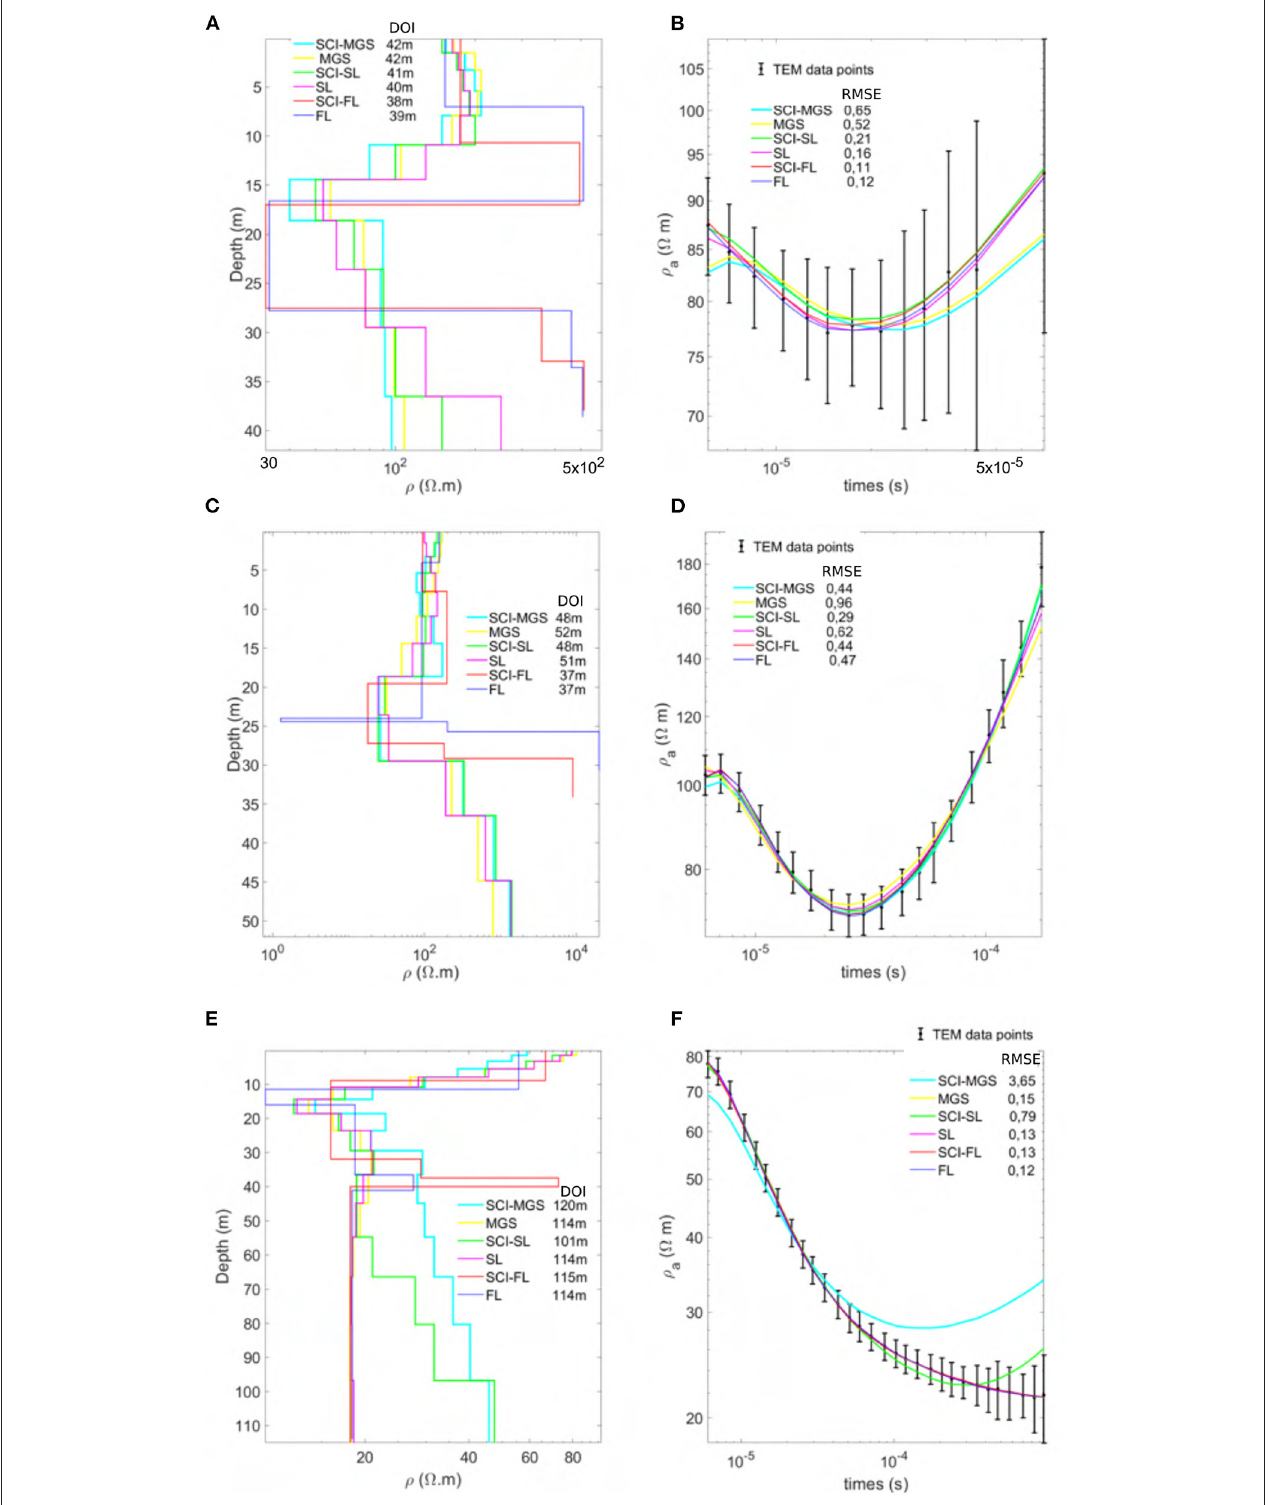
FIGURE 3 | Example of the different inversion scheme results for three TEM soundings in distinct areas of the catchment. (A,C,E) 1D resistivity models; in the text box we show their maximum depth of investigation (DOI). (B,D,F) measured TEM data point and fitted apparent resistivity curves accordingly to the different inversion scheme [minimum gradient support (MGS), smooth model (SL), few layers (FL), individual and spatially constrained inversion (SCI)]; in the legend we give the RMSE value of each inversion scheme result. The measurement points belong to (A,B) the Andes mountain range ( Supplementary Figure 2A ), (C,D) the transversal mountain range ( Supplementary Figure 2D ), (E,F) the pediplanes of the coastal mountain range ( Figure 8B ).